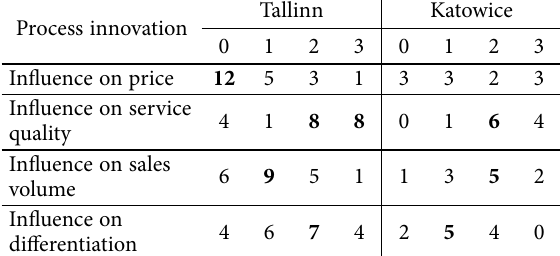
Table 5. Organisation innovation influences the in air cargo